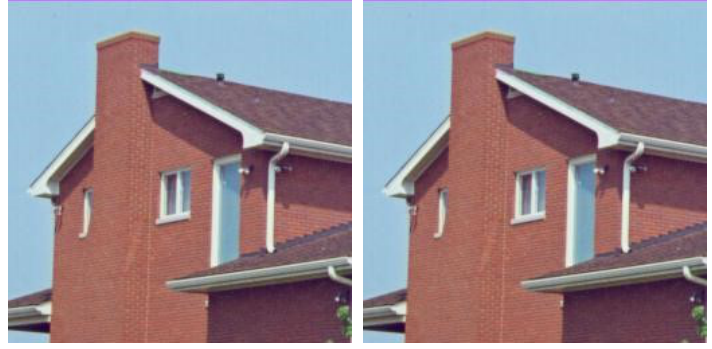
Figure 8. We have injected faults for a benchmark jpeg. Even though faults change the size of the output image, the visual difference between the original and fault image is almost